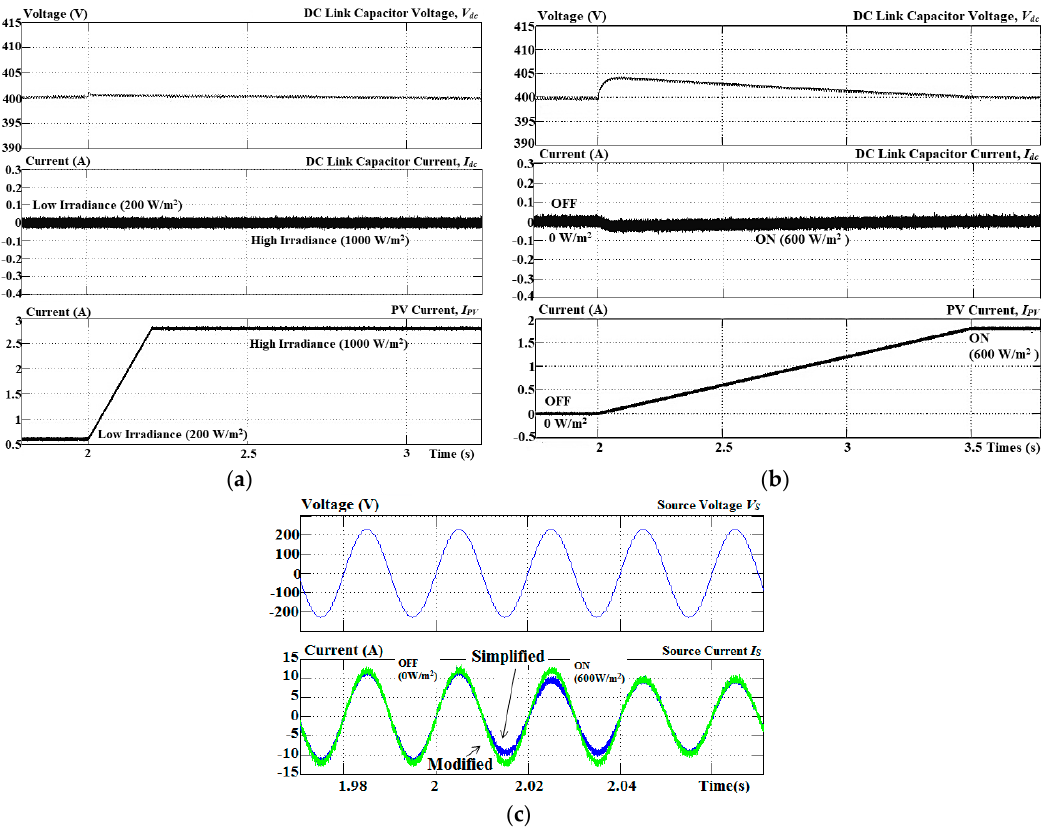
Figure 10. Simulation results of DC link capacitor voltage under off–on operation between PV and SAPF by using ( a ) step size error cancellation and ( b ) direct control in self-charging algorithms; ( c ) performance of current harmonics extraction algorithms.